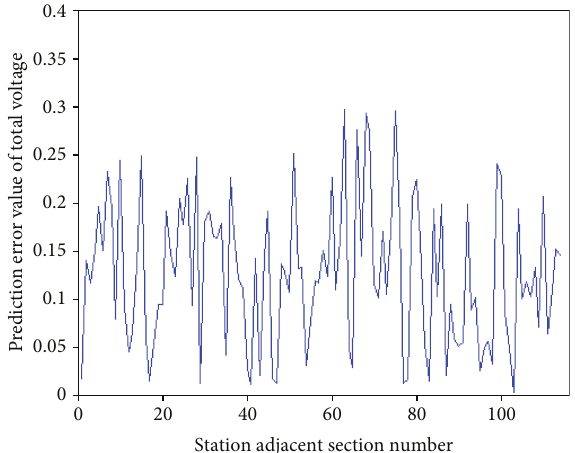
Figure 8: In fl uencing factors ’ prediction error (total